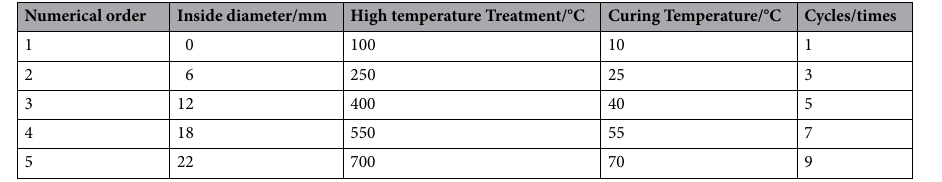
Table 1. Static and dynamic test variable factors of circular granite under water-heat cycles conditions. 1. High temperature treatment: The specimens were heated at a heating rate of 2 °C/min until the temperature arrived at set temperature, then the temperature were kept constant for 2 h. 2. Water curing: The high-temperature specimens were cooled down to a set temperature under natural condition, and then the specimens were immersed in water at the same temperature for 1 h. 3. One cycle heat recovery: It includes one high temperature treatment and one water temperature curing.